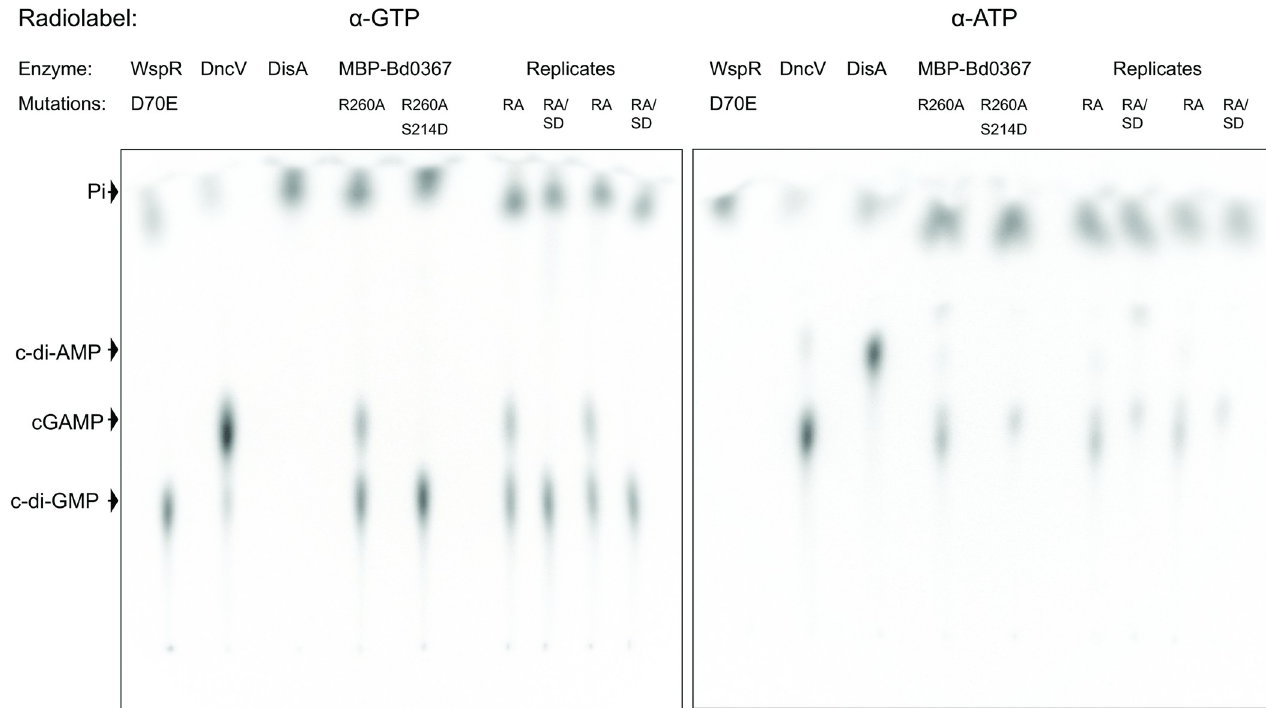
Fig 2. Bd0367 produces different cyclic dinucleotides. Cellulose TLC analysis of radiolabeled products from enzymatic reactions with 1:1 ATP-to-GTP substrates in excess and doped with trace amounts of α - 32 P-labeled GTP (left panel) or α - 32 P-labeled ATP (right panel). Before loading, reactions were quenched with alkaline phosphatase to digest unreacted nucleotides, resulting in production of inorganic phosphate (Pi). Residue R260 of Bd0367 is located in the putative I-site. Residue S214 is located at the selectivity position identified in previous studies and is necessary for cGAMP, but not c-di-GMP, production as mutants (S214D, SD) showed no bands at the expected position (cGAMP) whereas positive controls (DncV and MBP-Bd0367 R260A) did. WspR D70E is a positive control for c-di-GMP production and negative control for cGAMP production. DisA is a positive control for c-di-AMP production and negative control for cGAMP